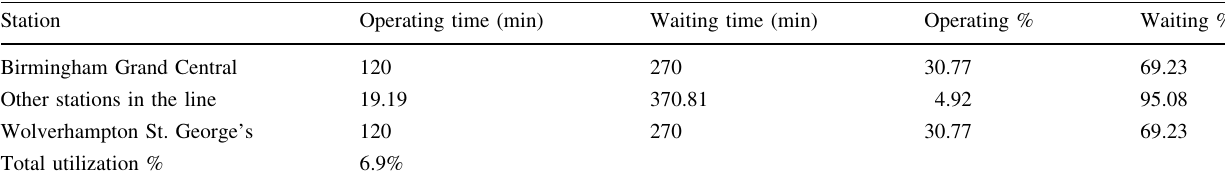
Table 7 Operating and waiting times of the system during super off-peak hours in clockwise direction Station